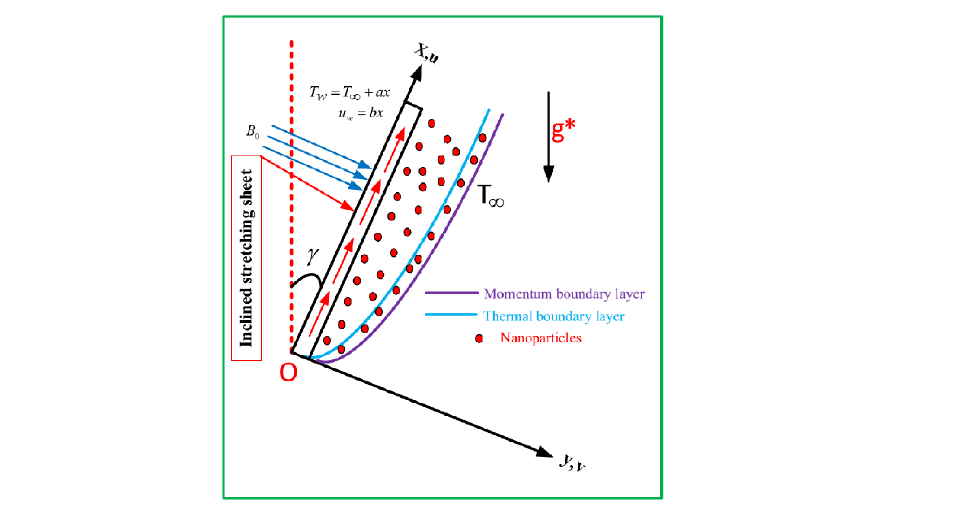
Figure 1. Geometry of model. Table 1. Thermophysical characteristics of water-based fluid and nanoparticles [40,41].